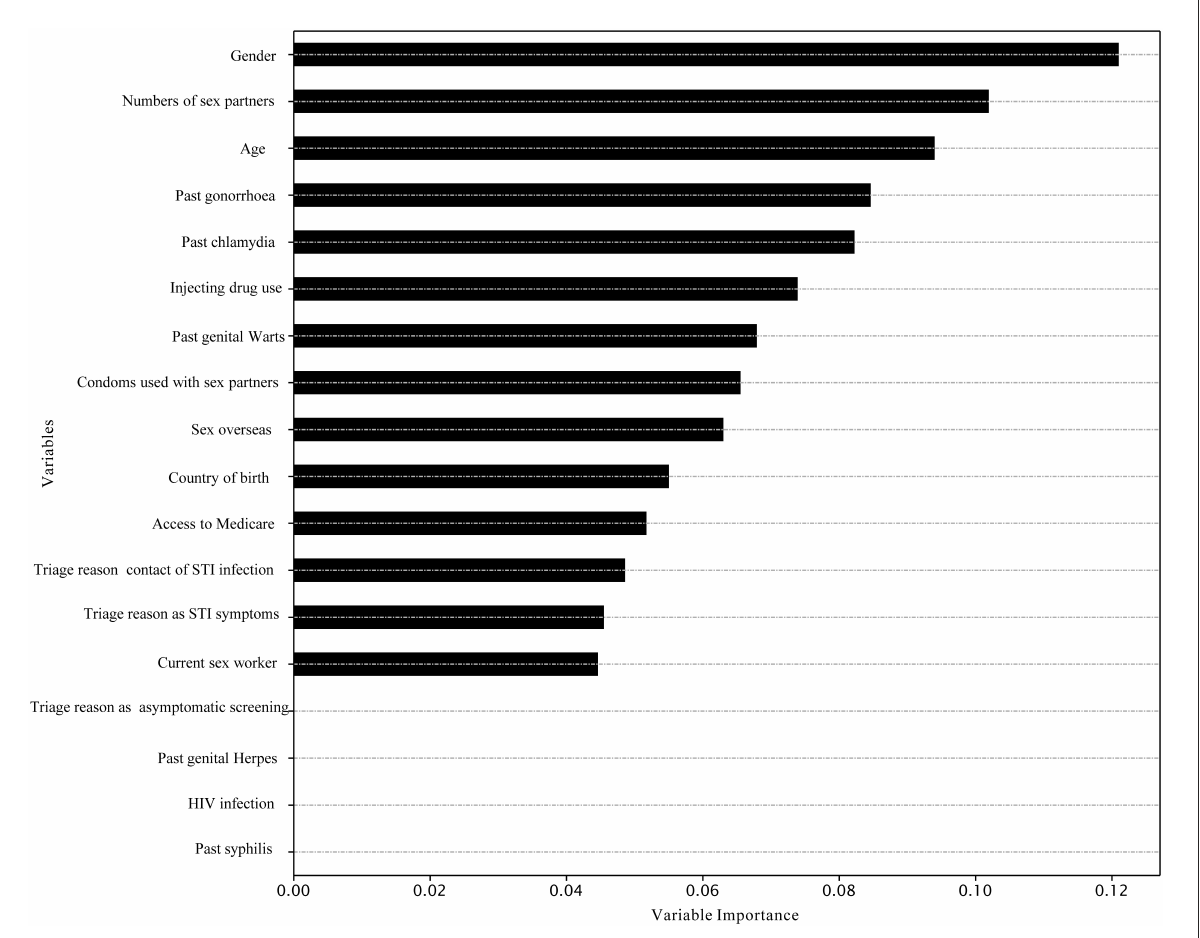
FIGURE2 Variable importance in the prediction of chlamydia re-infection within 1 year among heterosexuals by XGBoost.